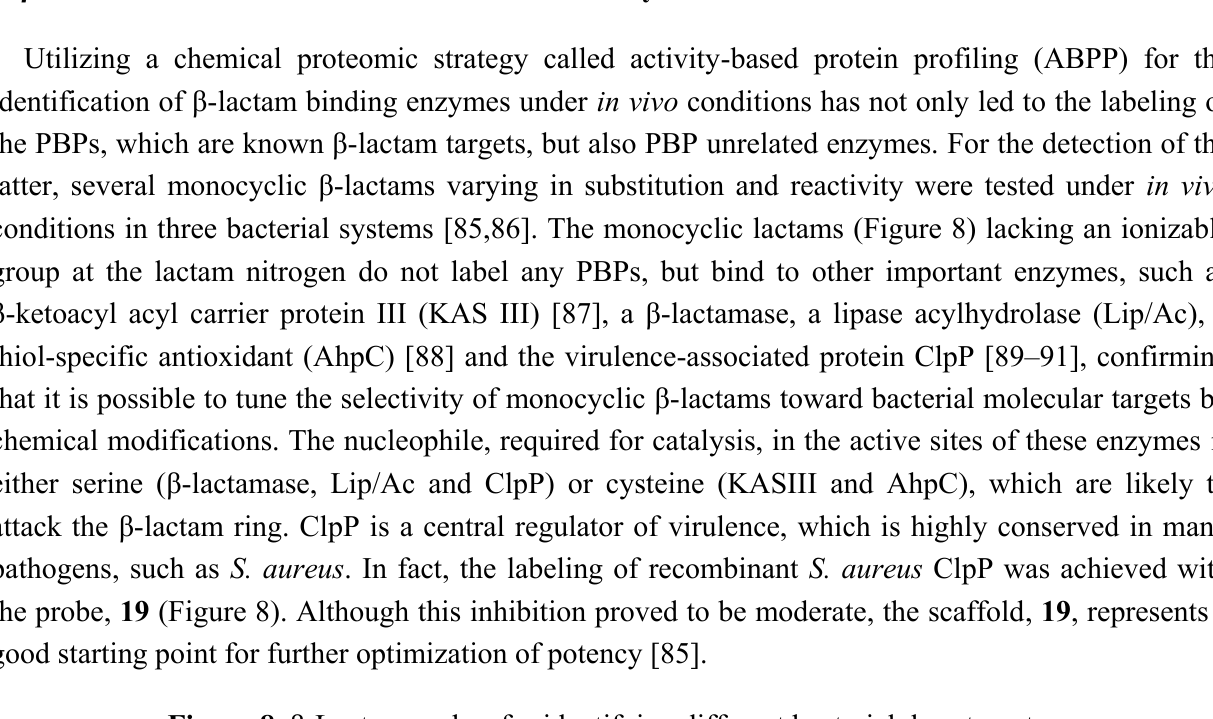
Figure 8. β-Lactam probes for identifying different bacterial drug